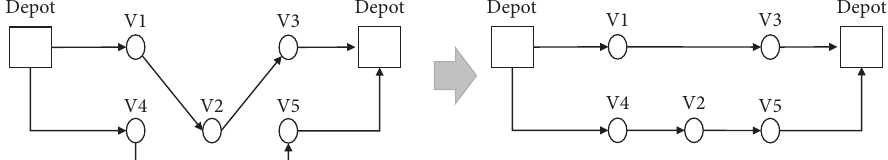
Figure 3: Relocation of a single route.